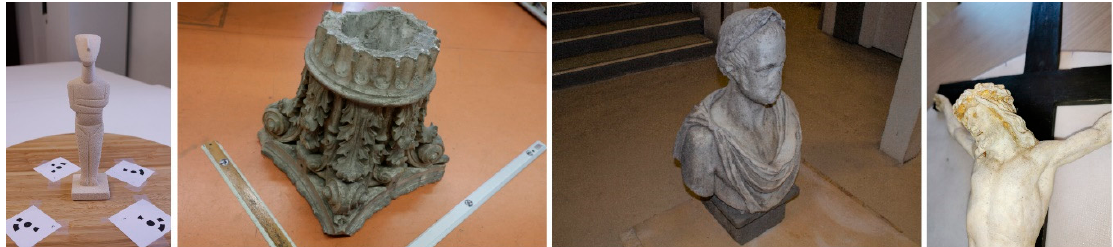
Figure 1. Case studies (from left to right): Cycladic figurine copy, Roman capital replica, stone bust of Francis Joseph I of Austria, and small sculpture of Christ Crucified.